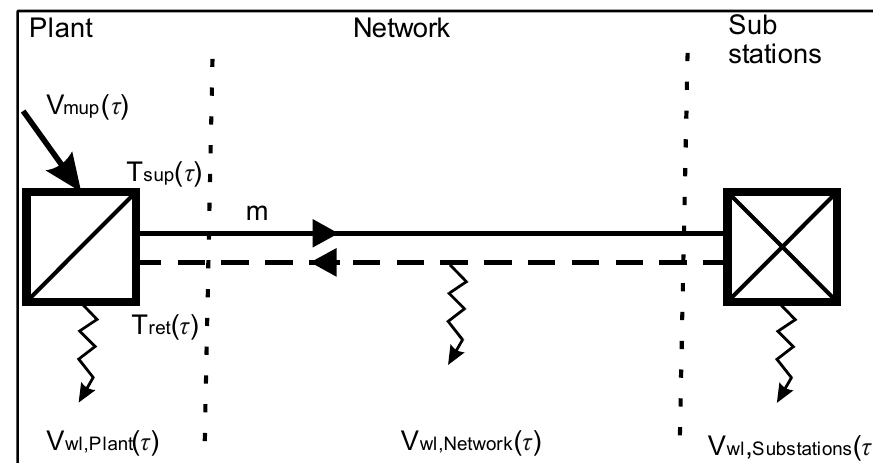
Figure 3. Diagram of a district heating network (DHN).